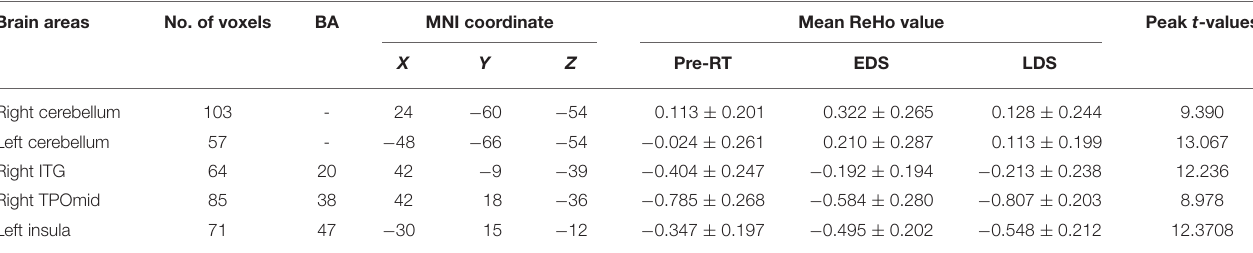
TABLE 3 | Regions of the brain in which the ReHo differ significantly among the pre-RT, EDS, and LDS in the patients with nasopharyngeal carcinoma post RT. Brain